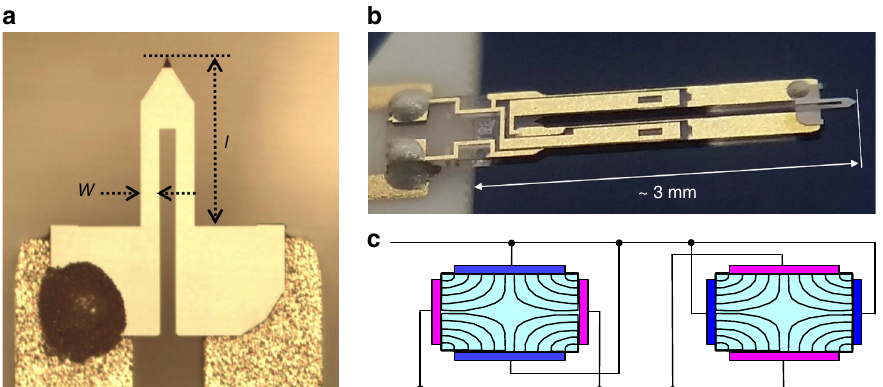
Fig. 6 NANOSENSORS ™ Akiyama-probe. a Photograph of the silicon cantilever highlights the attachment to the quartz tuning fork (reproduced from http://www.akiyamaprobe.com). Glue lies between the silicon and ends of the tuning fork legs. The left contact is covered in silver epoxy to ground the tip of the cantilever in AFM 30 (http://www.akiyamaprobe.com). b Photograph of the gold-covered quartz tuning fork and the silicon cantilever (reproduced from http://www.akiyamaprobe.com). c Cross-sectional area of the quartz tuning fork, where the drive and pickup gold contacts along the length of the lever are represented by blue and pink, respectively. The quadrupolar electric fi eld induces motion in the tuning